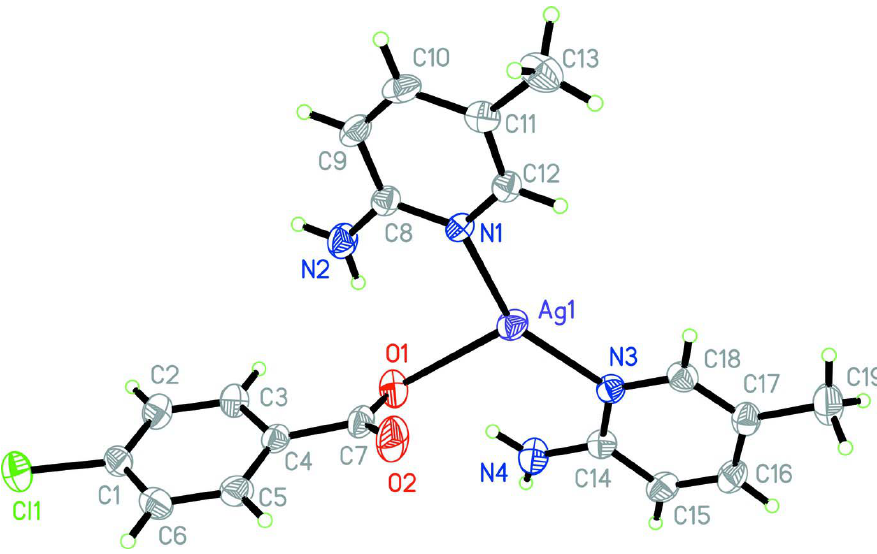
Figure 1 The structure of the title complex, showing 30% probability displacement ellipsoids and the atomic numbering.